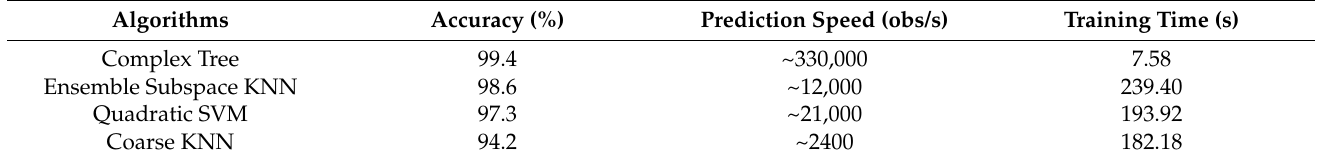
Table 5. Performance of ML